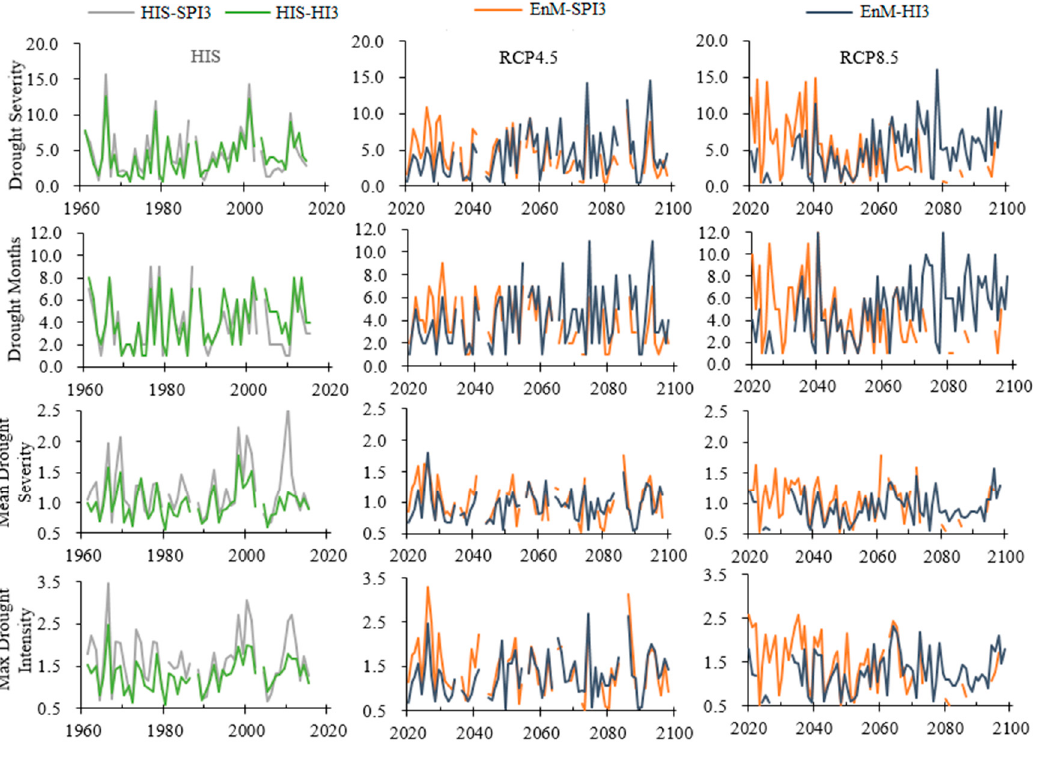
Figure 5. Inter-annual changes in characteristics of extreme drought in the past and the future.